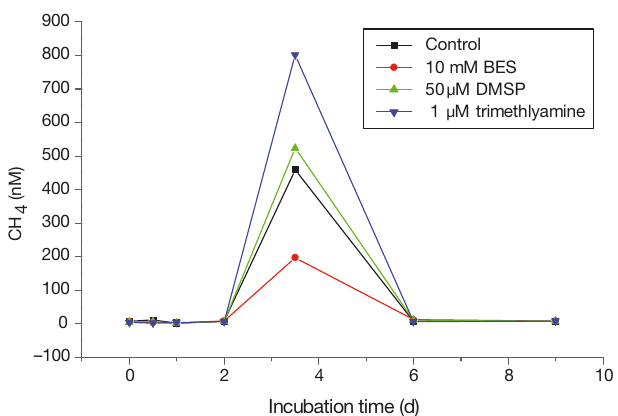
Fig. 10. CH 4 time series incubation experiments at Station MC (see Fig. 2) during October 2013. BES: 2-bromoethane